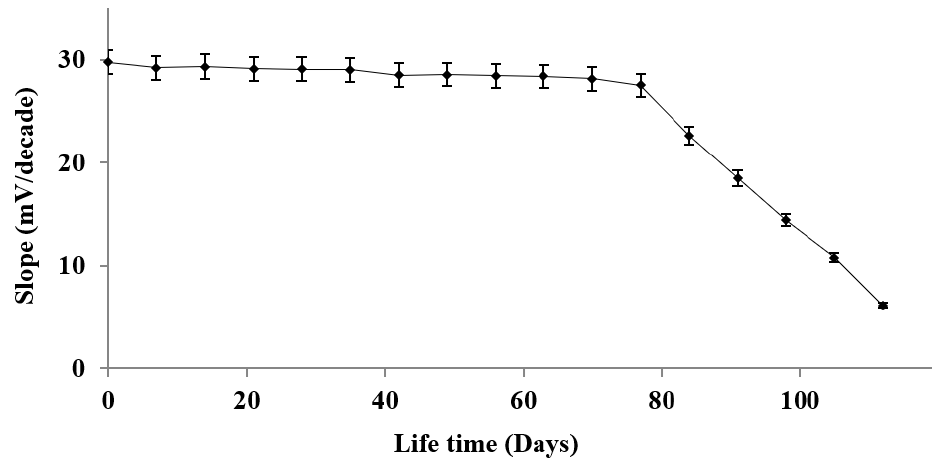
Figure 9. Life time of the proposed Hg 2+ -SE for a period of 112 days. Table 3. Selectivity coefficients of proposed Hg 2+ –SE (ISE-7) for different interfering ions calculated using MPM at optimized conditions.